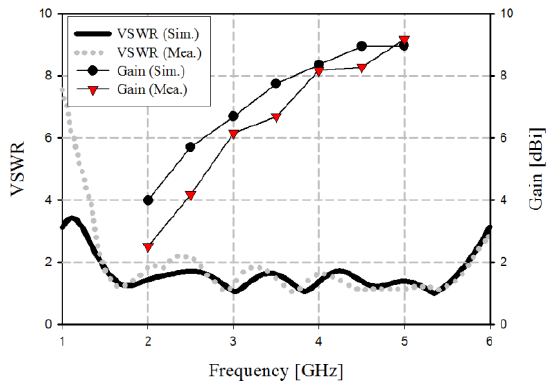
Figure 3. Results of the impedance bandwidth.